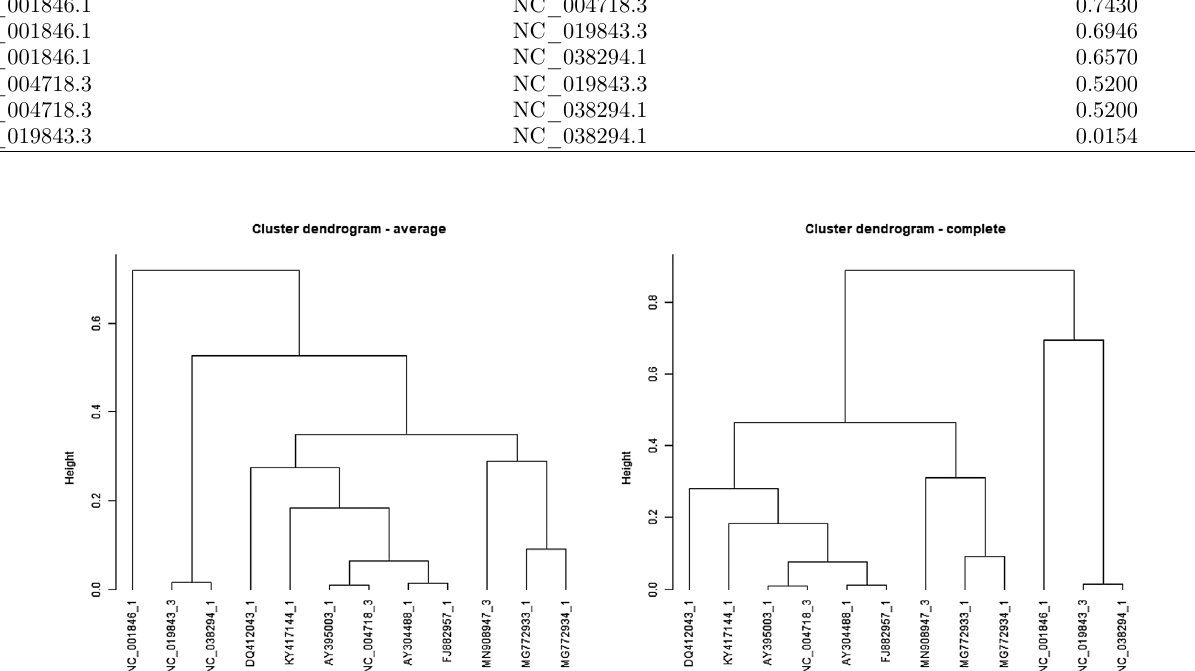
Figure 2. Dendrograms build from the d max values, reported in Table 10. MN908947.3 Covid-19